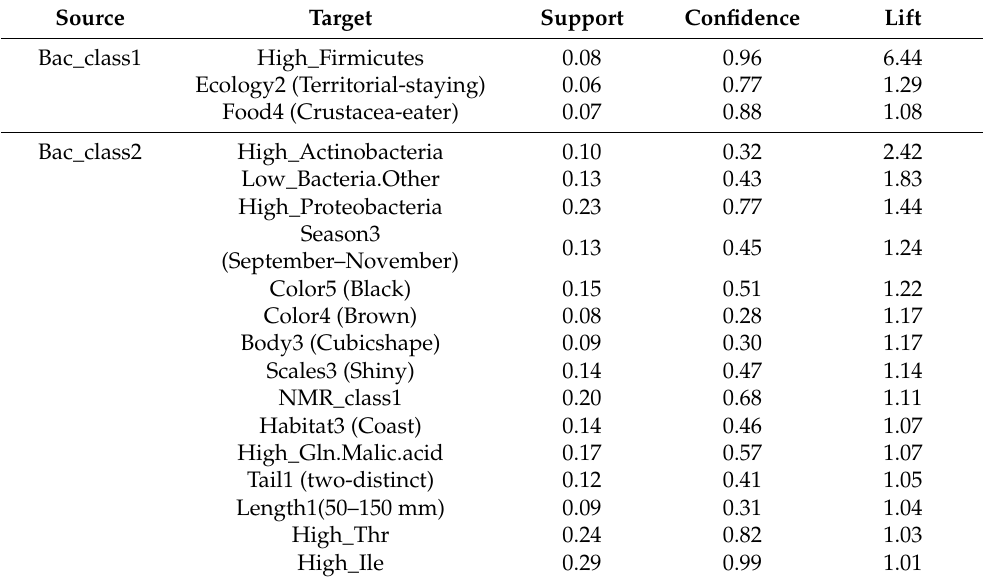
Table 3. Extracted association-rule-correlated bacterial class information from i-means result to other